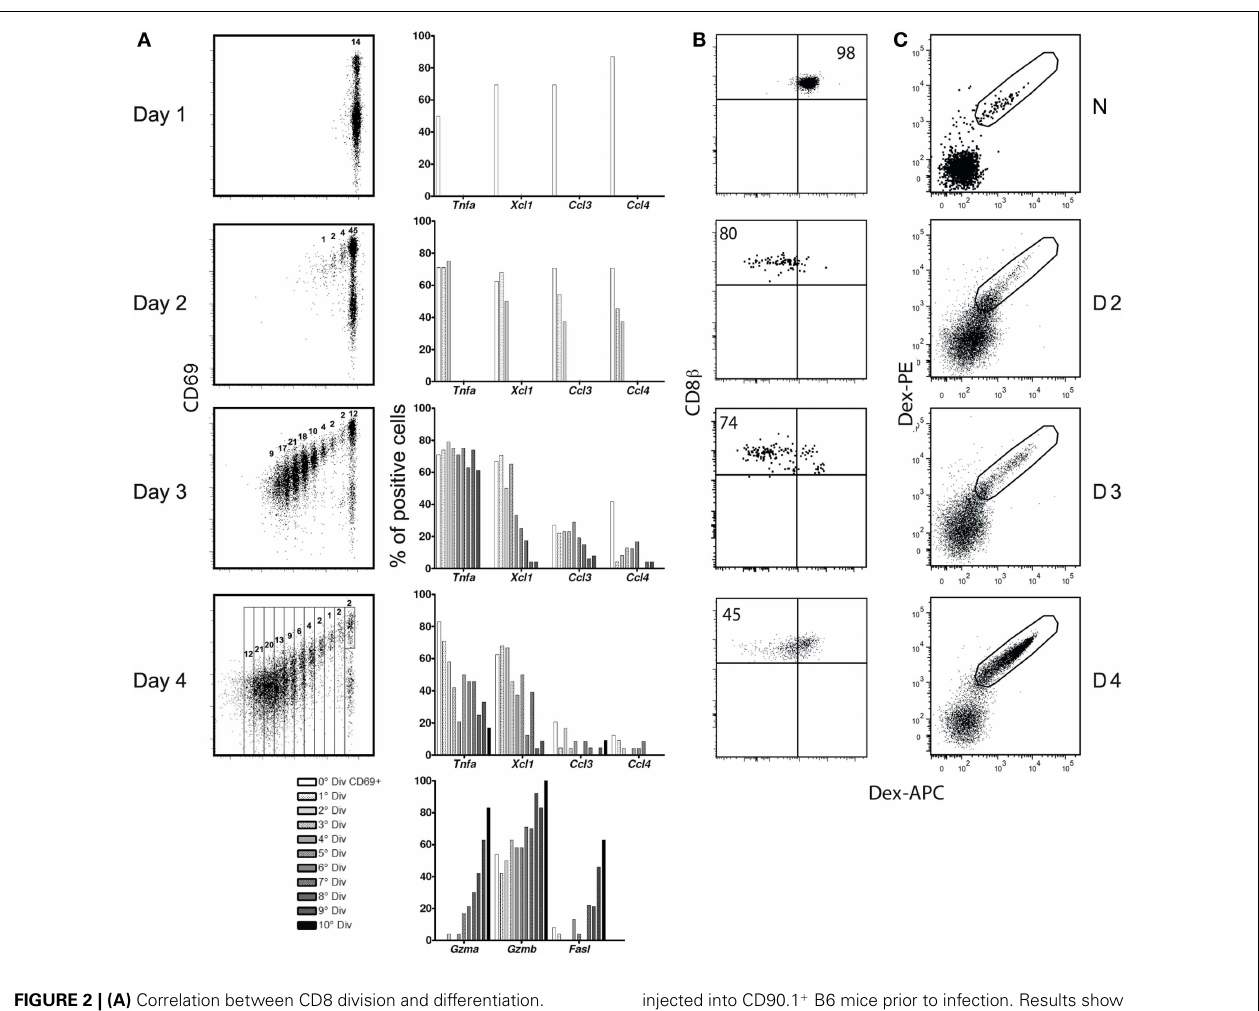
FIGURE 2 | (A) Correlation between CD8 division and differentiation. (A) CFSE-labeled Mo CD90.2 OT-1Tg cells were transferred to CD90.1 B6 mice and studied at different time points after infection with LM-OVA. Left: CFSE dilution and the gates used to sort individual cells at each division. Right: expression frequency, as evaluated in RT-PCRs in 96 individual cells. (B,C) TCR expression after immunization with LM-GP33. (B) TCR-Tg cells. 5,000 Mo CD90.2 + P14TCR-Tg cells were